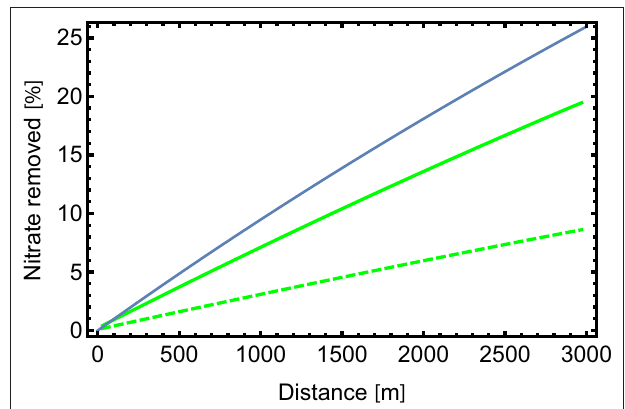
FIGURE 6 | Percentage of incoming nitrate removed vs. travel distance for the ADELS model (solid curve) and the mTSM model (dashed curve) for a variant case with higher incoming DOC.